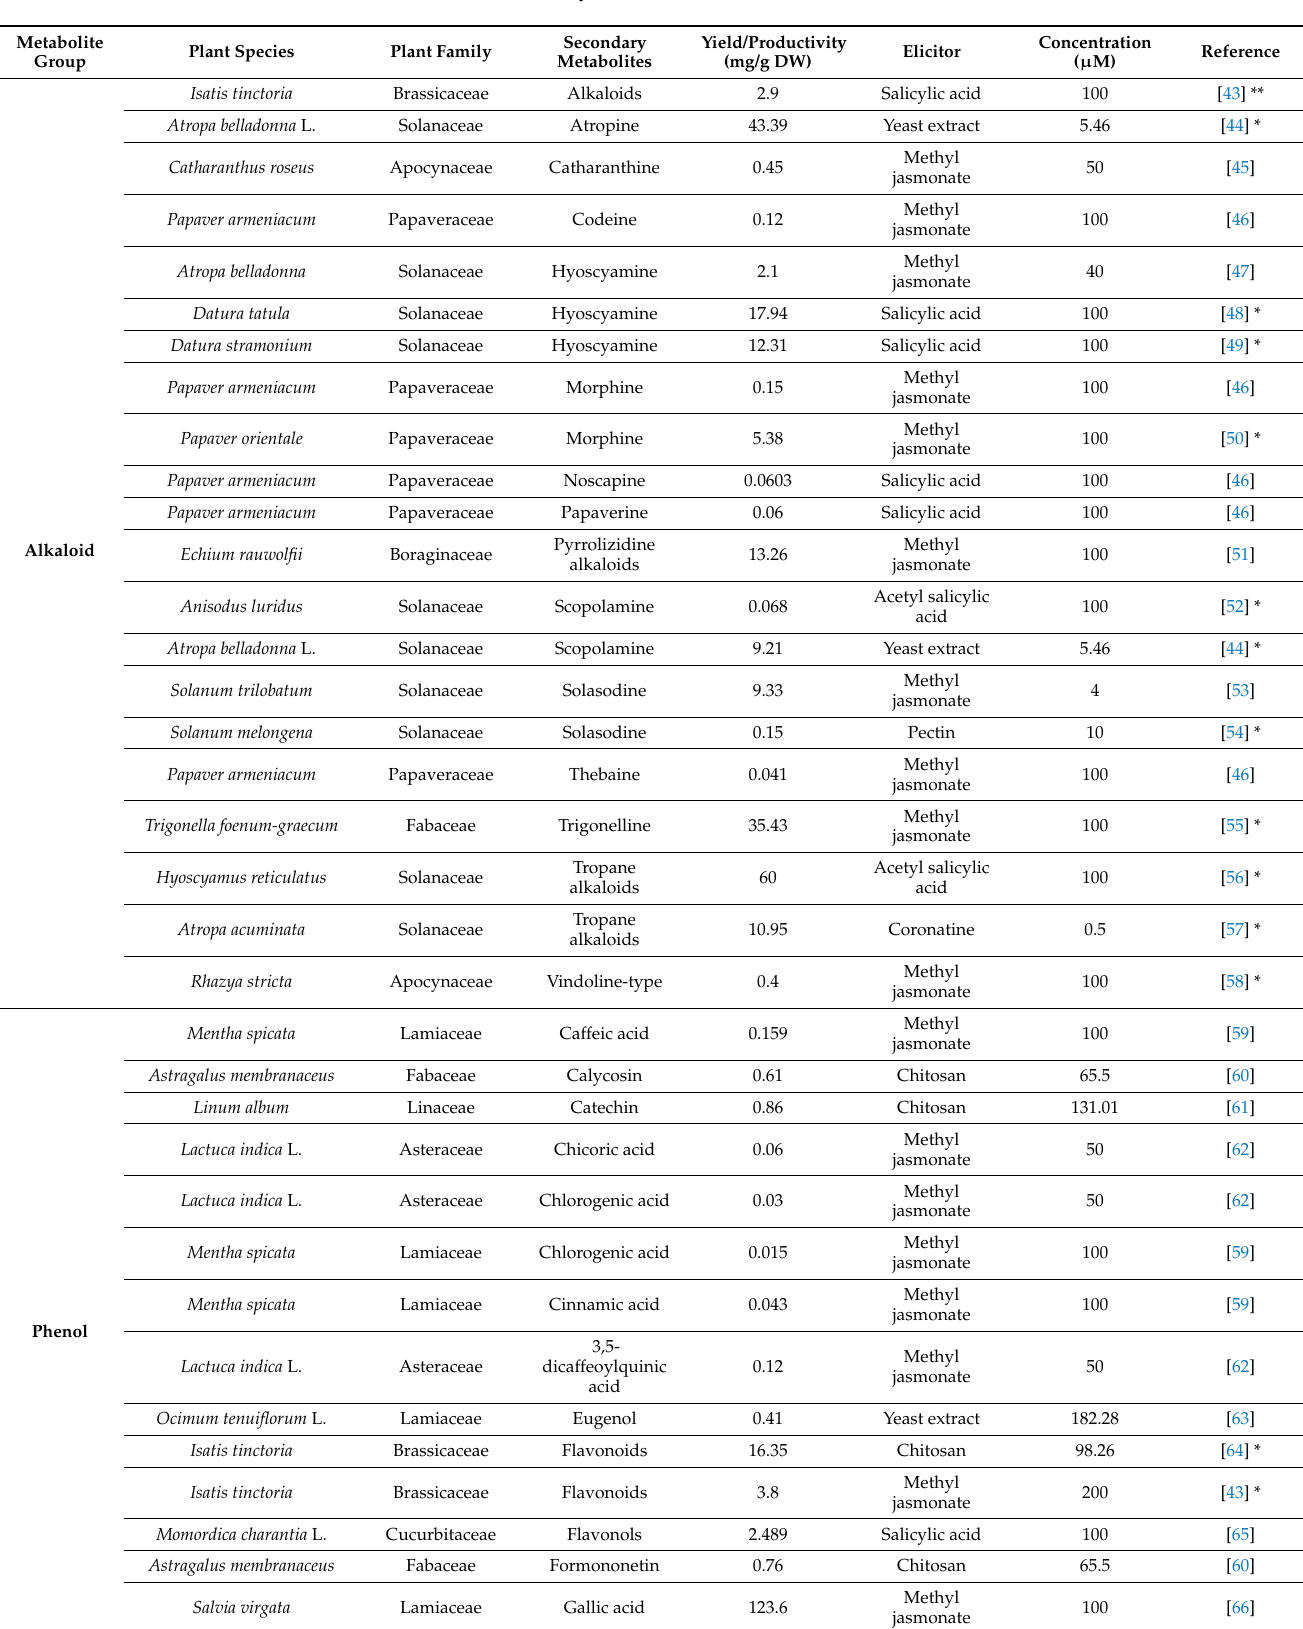
Table 1. Elicitation in hairy roots from 2010 to